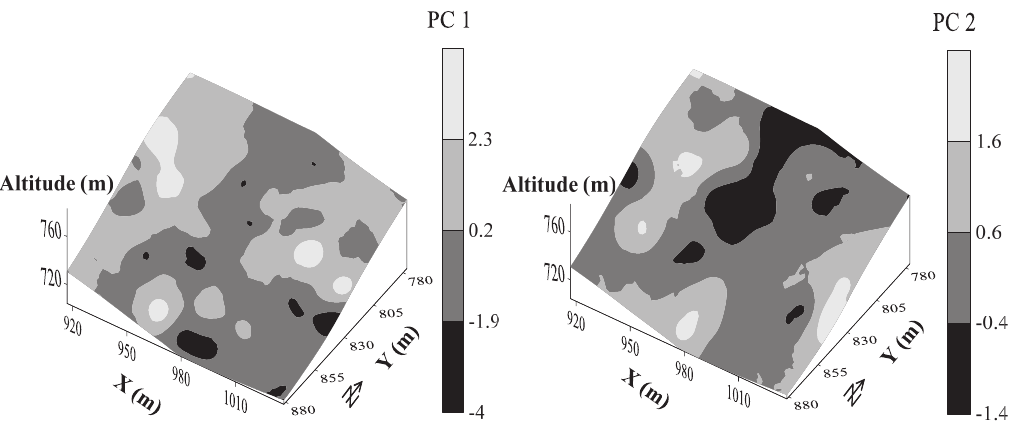
figure 6. thematic maps based on the first two principal components (pc1,